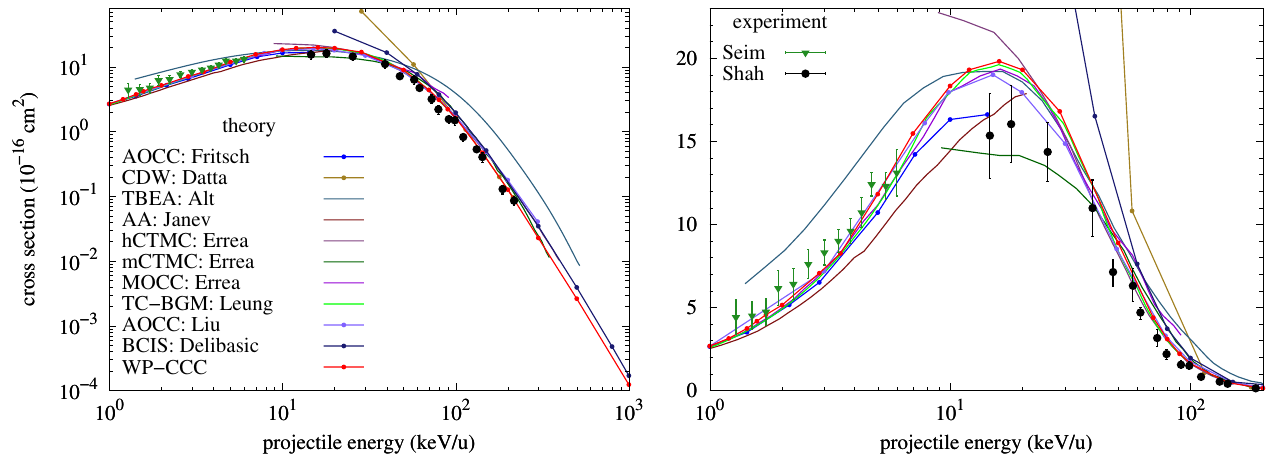
Figure 2. The total cross section for electron capture in Li 3 + − H(1s) collisions calculated using the WP-CCC method. Experimental measurements are by Shah et al. [8] and Seim et al. [9]. Also